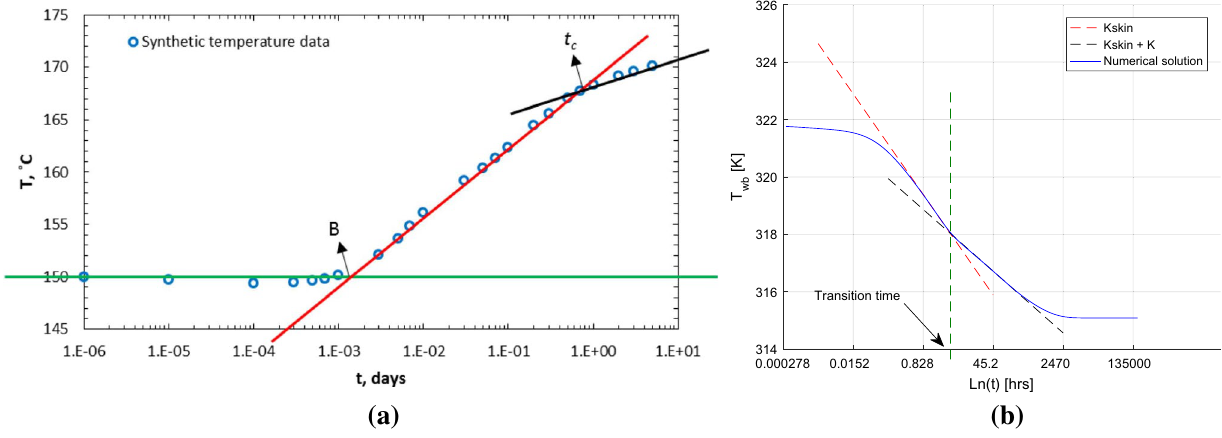
Fig. 2 Plot of numerical transient wellbore temperature showing slope change due to damage skin a for an oil producing well, the red solid line is the slope for the damage region, while the black solid line is the slope for the virgin formation, Mao and Zeidouni (2017) b for